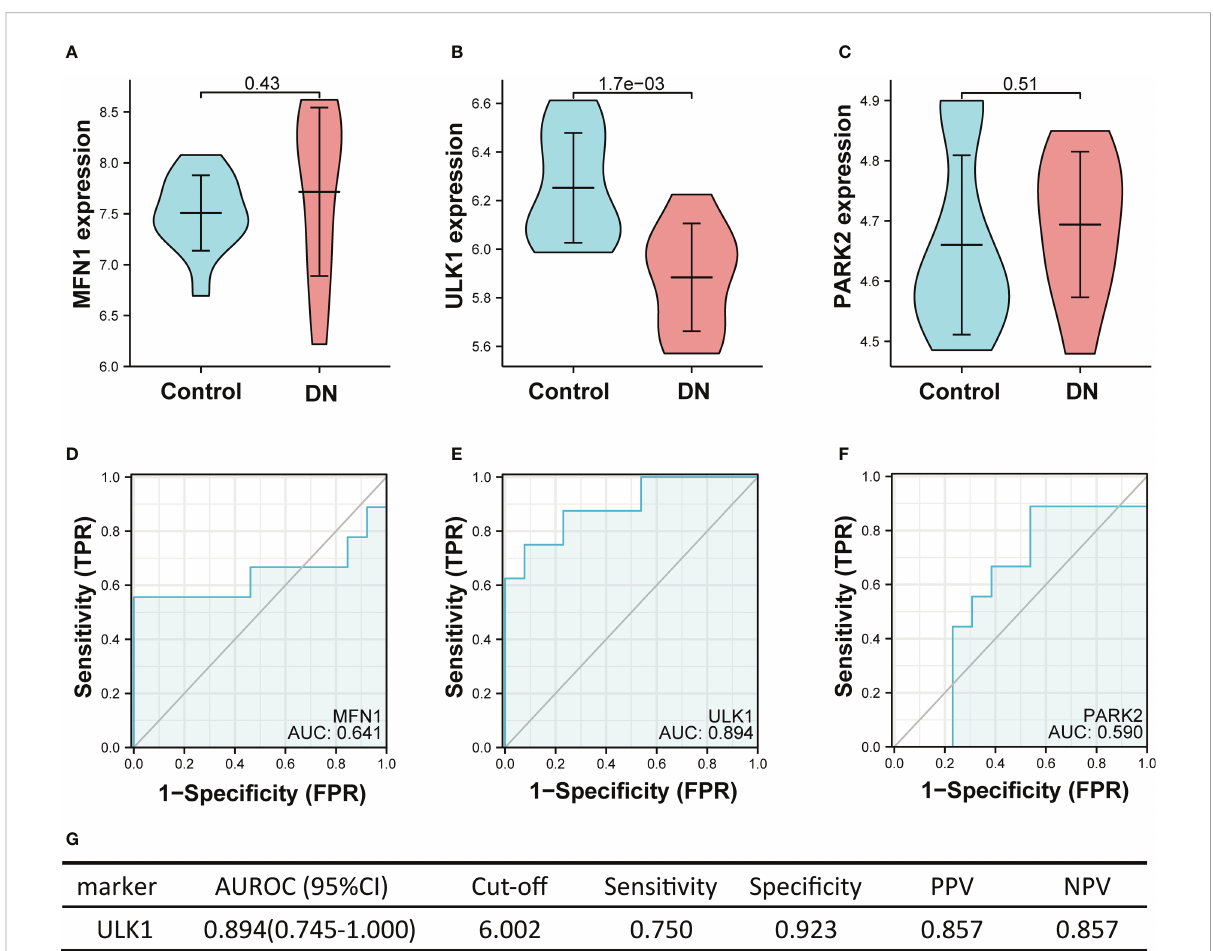
FIGURE 7 The performance of the three hub genes to diagnose DN in the validation set. (A-C) Expression difference of the three hub genes between DN and control groups. (D – F) The ROC curve of the three hub genes in DN and control groups. (G) Diagnostic value of ULK1 for differentiating DN from control groups. PPV, positive predictive value; NPV, negative predictive value; AUROC, area under the receiver operating characteristics curve; CI, con fi dence interval. Data were analyzed by Wilcoxon tests or Student ’ s t